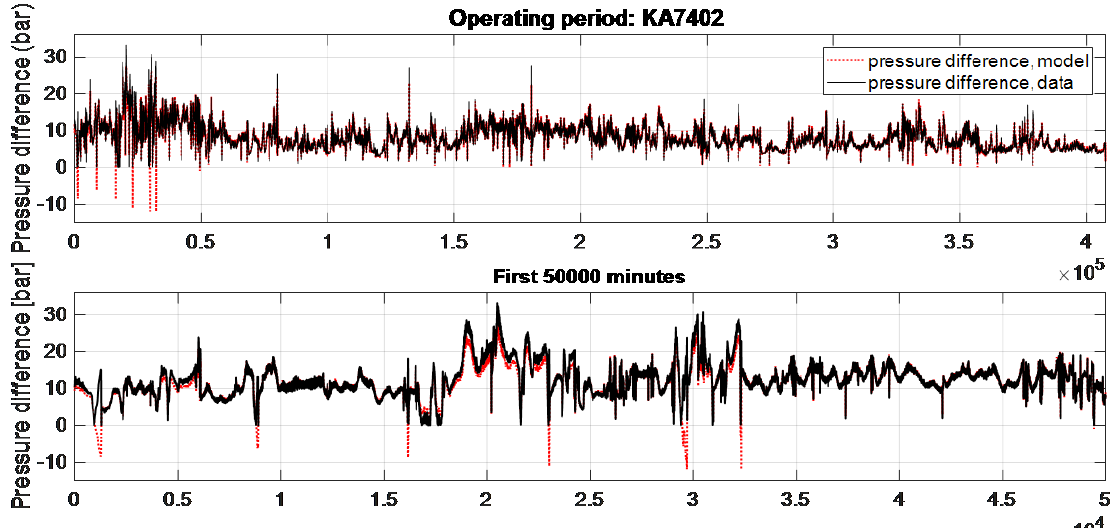
Figure 7: Fitting of best model to training data set for booster pump KA7402